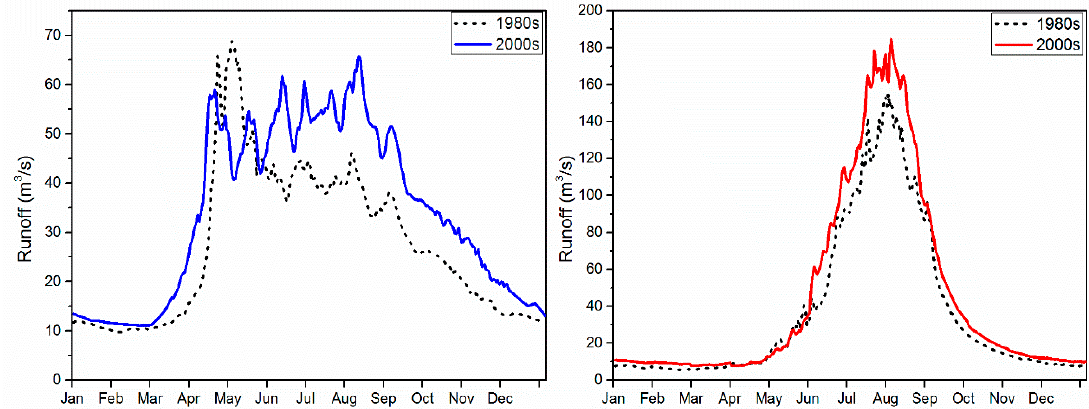
Figure 5. Runoff time series between the 1980s and 2000s. Left: the Kaidu River Basin, right: the Manas River Basin.